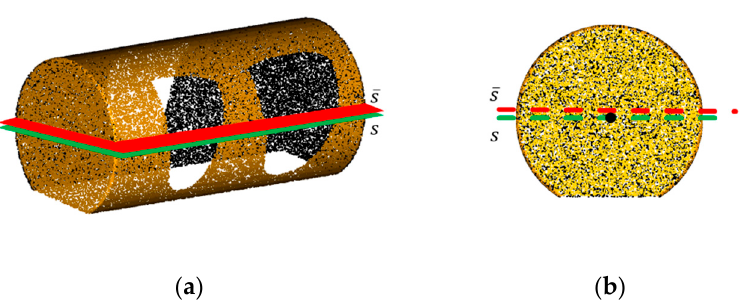
Figure 12. Example of the symmetry plane of point cloud: ( a ) cylinder point cloud with holes; ( b ) side view of point cloud.